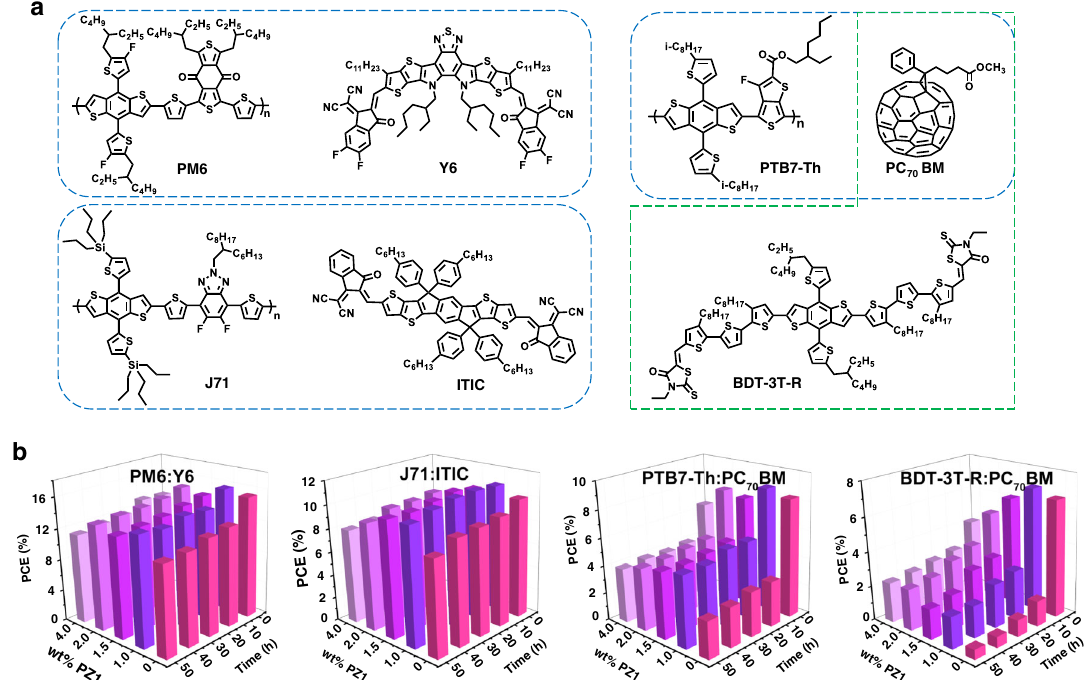
Fig. 5 Chemical structures and thermal stability of photovoltaic systems. a Molecular structures of four photovoltaic systems, including PM6:Y6, J71: ITIC, PTB7-Th:PC 70 BM, and BDT-3T-R:PC 70 BM. Normalized photovoltaic performance of investigated ( b ) PM6:Y6, J71:ITIC, PTB7-Th:PC 70 BM, and BDT- 3T-R:PC 70 BM blends doped by PZ1 additives as a function of annealing time at 150